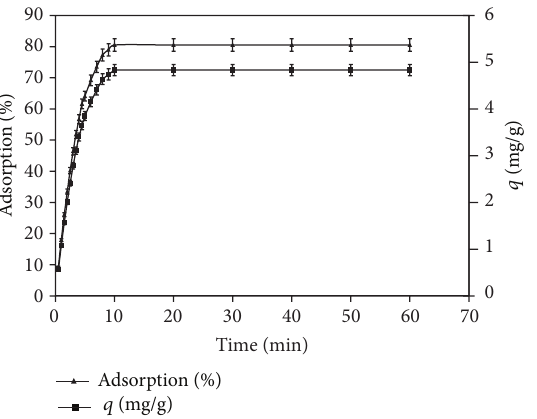
Figure 3: Effect of metal concentration on the biosorption of lead by Ficus benghalensis L. at 0.1g/30 mL of biosorbent concentration and solution pH of 6.0.